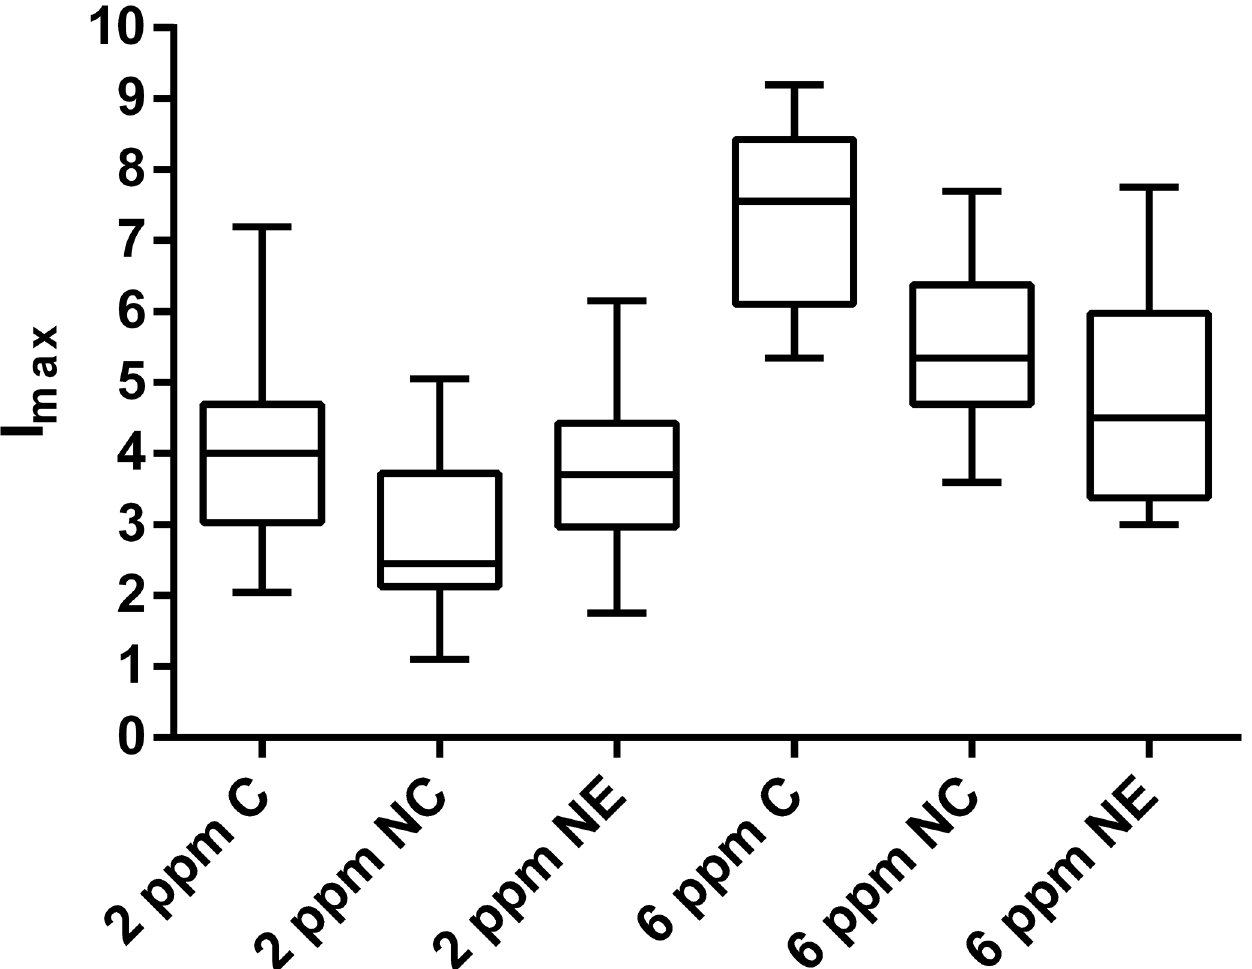
Fig 7. Pungency intensity tests of the nanoformulations in comparison to free capsaicin. Sensory evaluation of pungency of the different nanoformulations in comparison to the free compound at different concentrations (scale: 0 – 10; 0 = “ not detectable ” , 10 = “ extremely pungent ” ). C = free capsaicin; NC = nanocapsules; NE = nanoemulsion. For statistical analysis refer to Table 4.